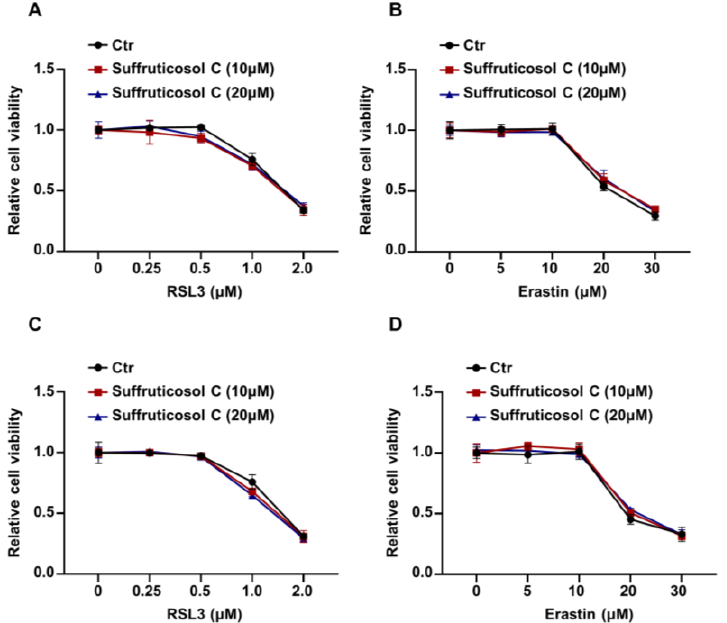
Figure 3. Ferroptosis-independent inhibitory effect of suffruticosol C on the growth of various can- cer cells. ( A , B ). HT29 cells were treated with different concentrations of RSL3 ( A ) or erastin ( B ) for 24 h in combination with indicated concentrations of suffruticosol C, and the viability of indicated cells was examined using CCK-8. ( C , D ). H1299 cells were treated with different concentrations of RSL3 ( C ) or erastin ( D ) for 24 h in combination with indicated concentrations of suffruticosol C,